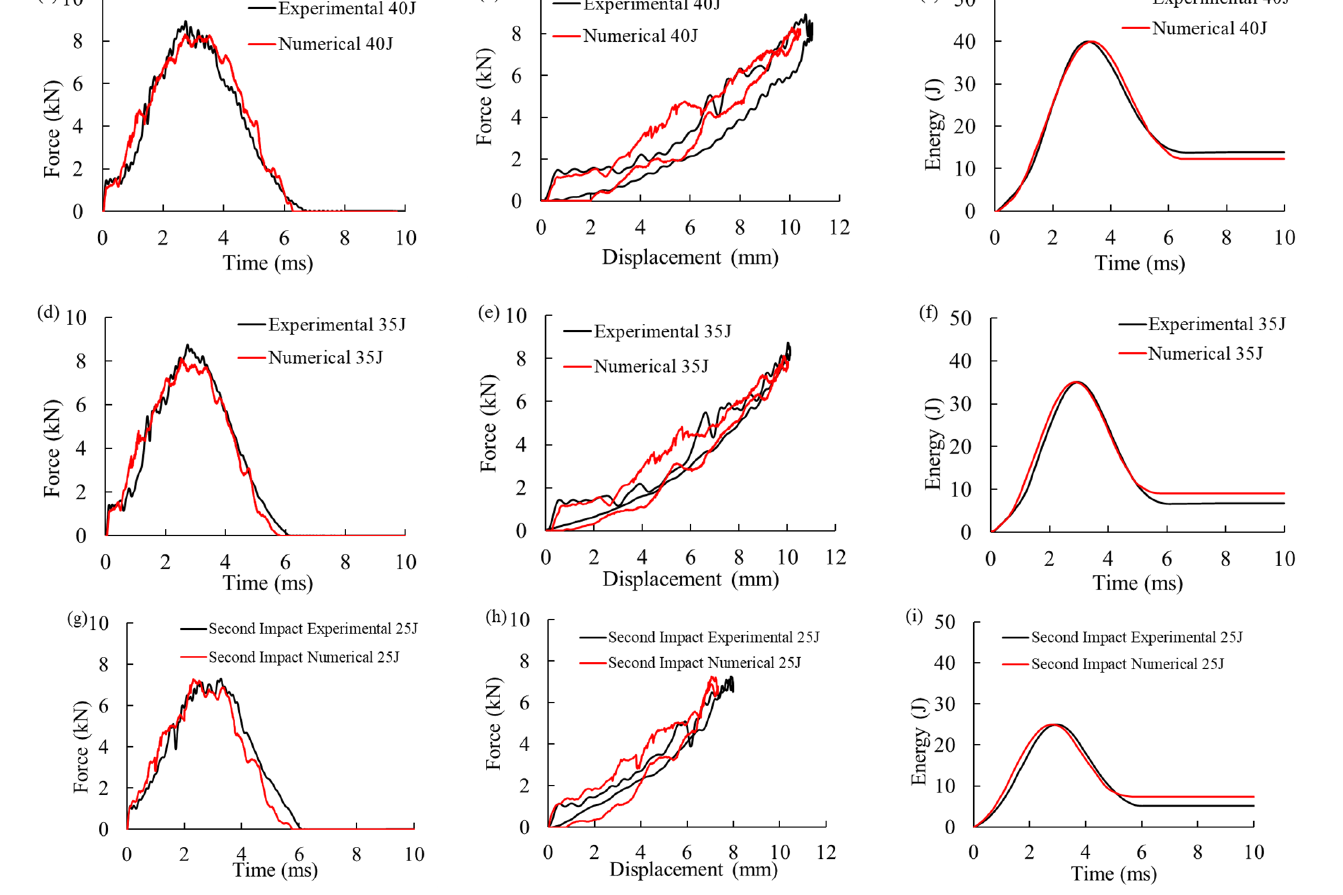
Figure 6. Experimental and numerical force–time, force–displacement, and energy–time curves for ( a – c ) Single impact at 40 J at the center, ( d – f ) Single impact at 35 J at the center, and ( g – i ) Second impact off ‐ center at 25 J (after the first impact at 40 J at the center).